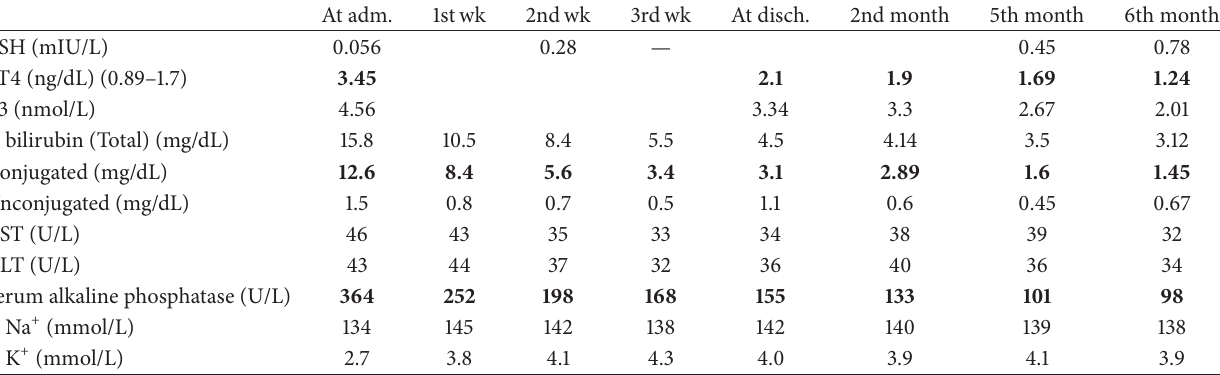
Table 2: Follow-up investigations of the patient.